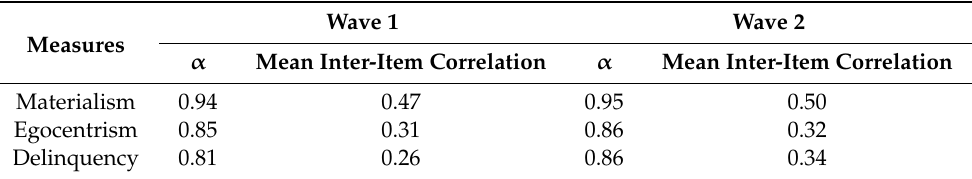
Table 1. Reliability of